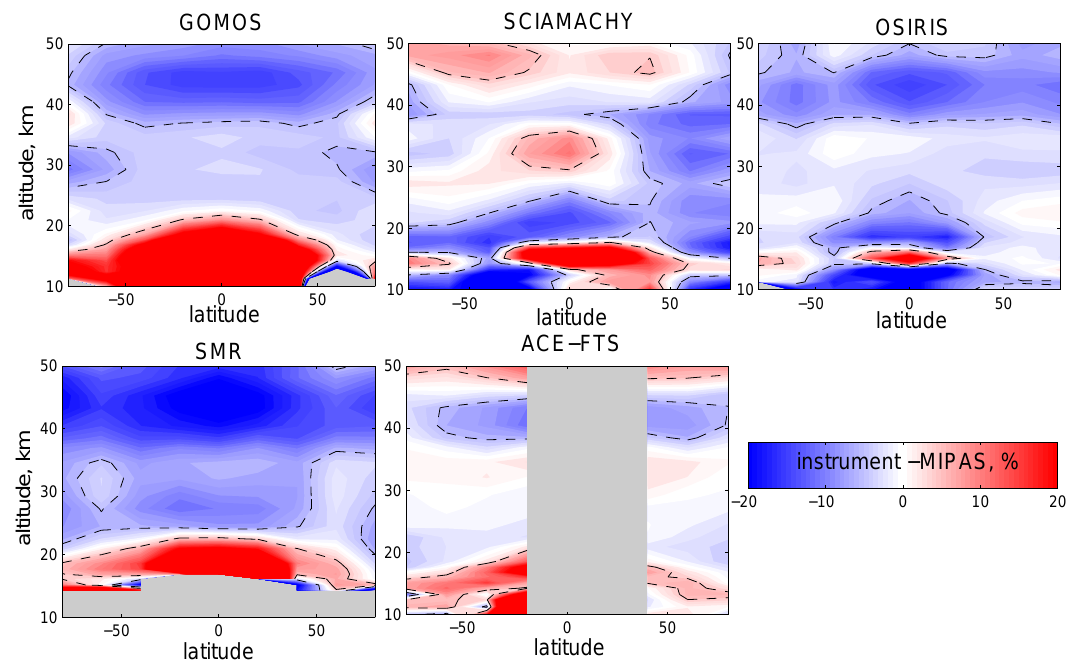
Figure 6. Latitude–altitude dependence of biases with respect to MIPAS (“instrument minus MIPAS” in % is shown in color scale). Dashed black lines indicate ±